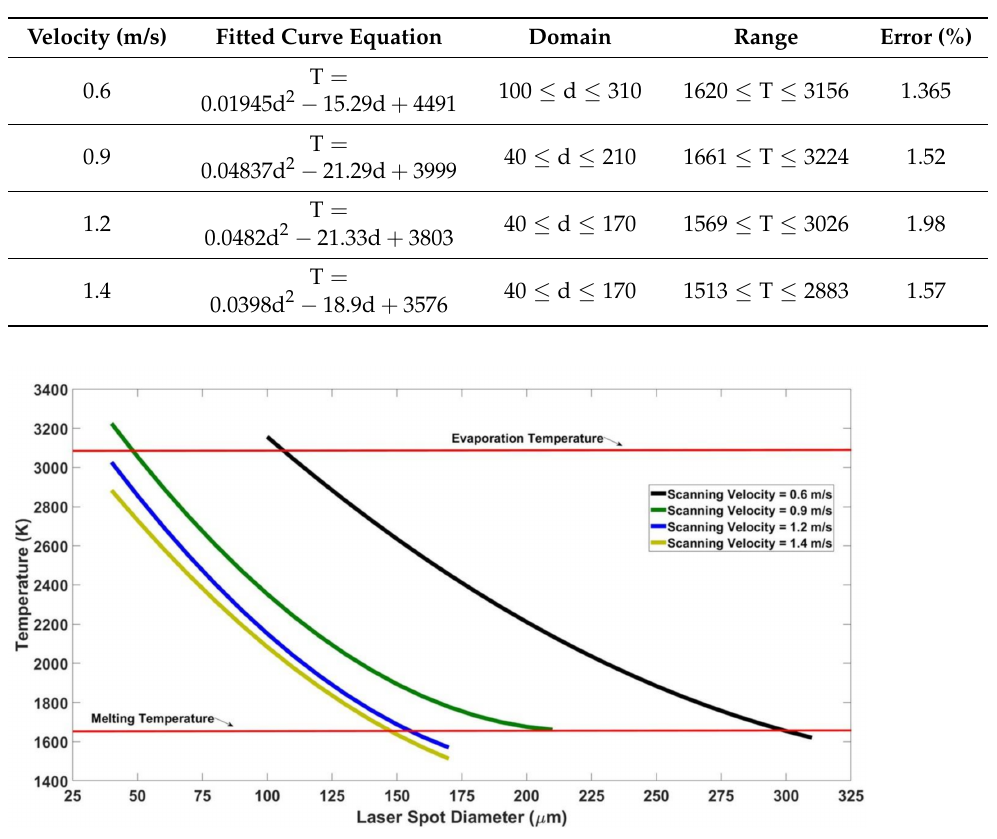
Figure 8. Fitted curves of laser spot diameter–temperature during various scanning velocities with a laser power of 150